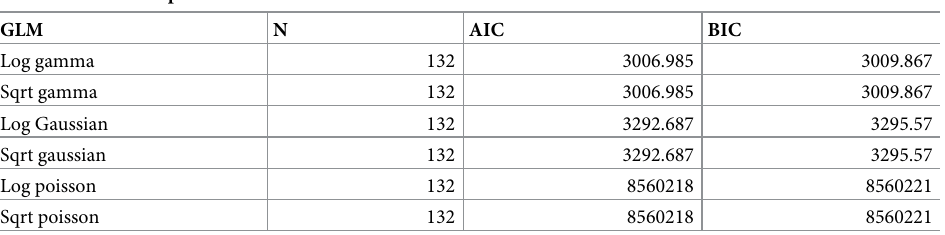
Table 6. Results of specifications tests.